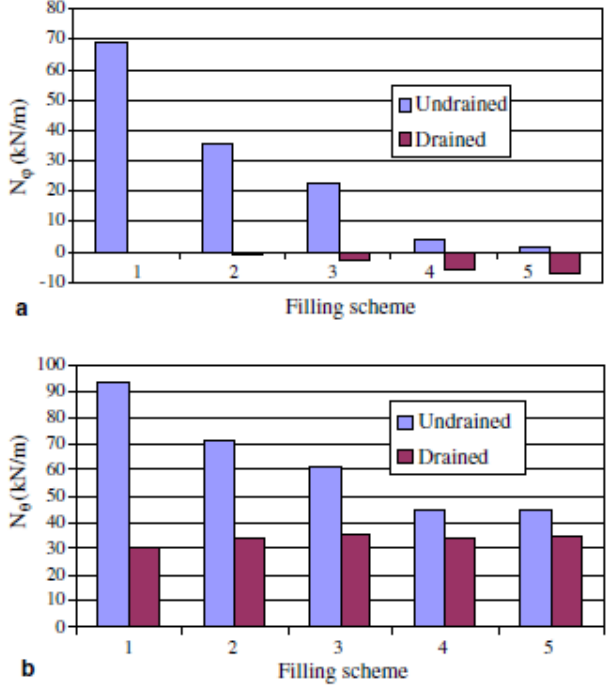
Figure 2. Distribution of the axial ( a ) and hoop ( b ) forces on the foundation of the silo [39].